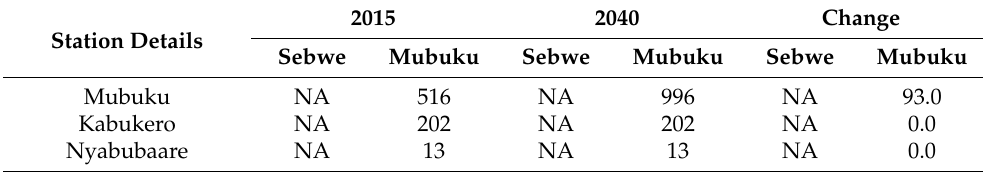
Table 8. Projected irrigation area (Ha) in Sebwe and Mubuku sub